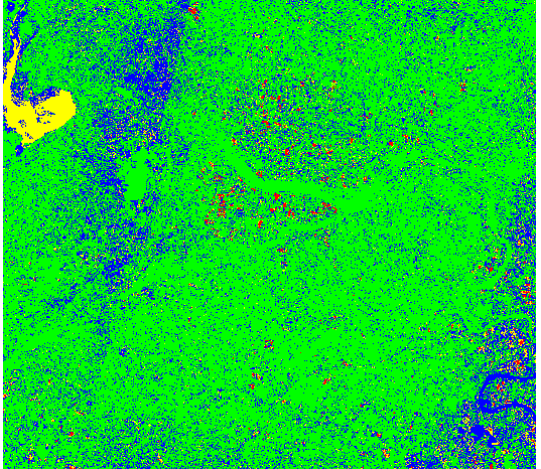
Figure 5. Color mapping of the differential DSM between the twin ZY-3 DSMs according to the standard deviation